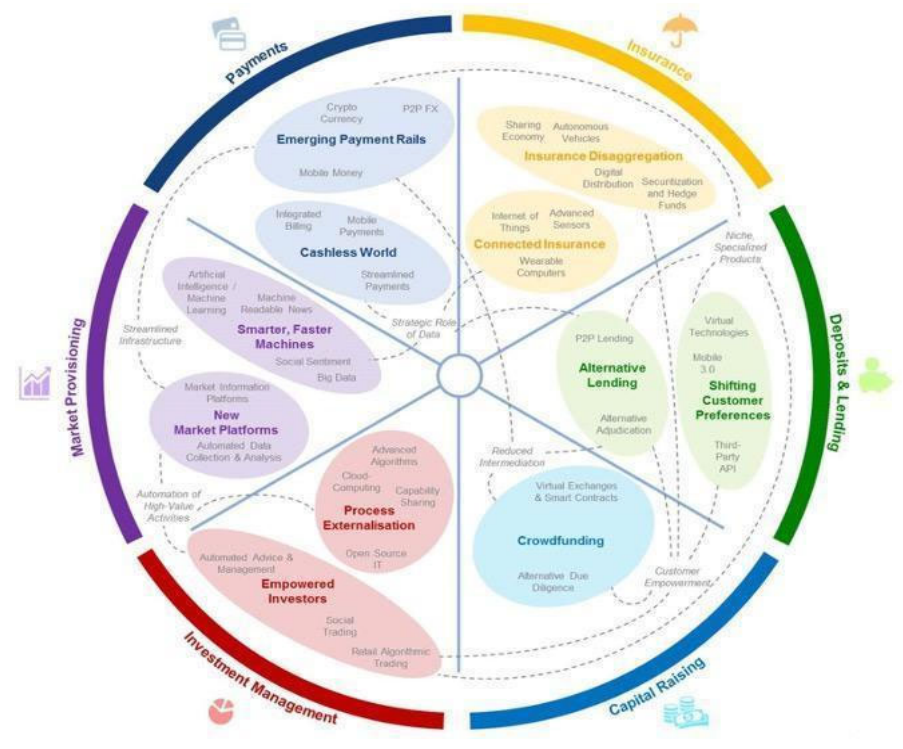
Figure A1. Global digital ecosystems. Source: see [65].